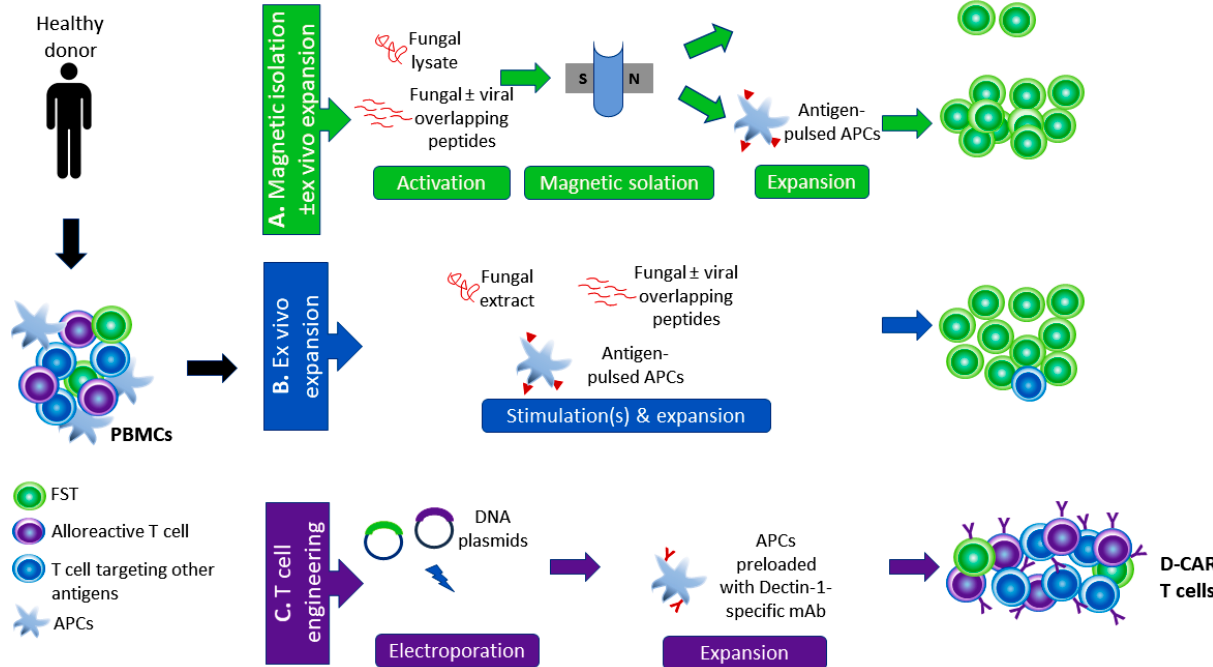
Figure 2. Strategies for mono-fungus-, multi-fungus- or multi-pathogen-specific T cell manufacturing. A: PBMCs collected from a healthy donor can be activated with fungal extracts or with overlapping peptide libraries of fungal and viral antigens and directly be selected ex vivo with monoclonal antibody capture of cytokine-producing cells or antibodies binding to activation antigens attached to magnetic beads. Selected cells can subsequently be expanded in culture. B: Alternatively, FSTs or multi-pathogen-specific T cells can be expanded ex vivo upon stimulation with fungal extracts or with overlapping peptide libraries of fungal and viral antigens. C: Finally, FSTs can be produced by genetically modifying T cells to express a chimeric antigen receptor (CAR) that redirects their specificity to a desired antigen, e.g., Dectin-1 (D-CAR T cells). FST: fungal-specific T cells; PBMCs: peripheral blood mononuclear cells; APCs: antigen-presenting cells; mAb: monoclonal antibody.